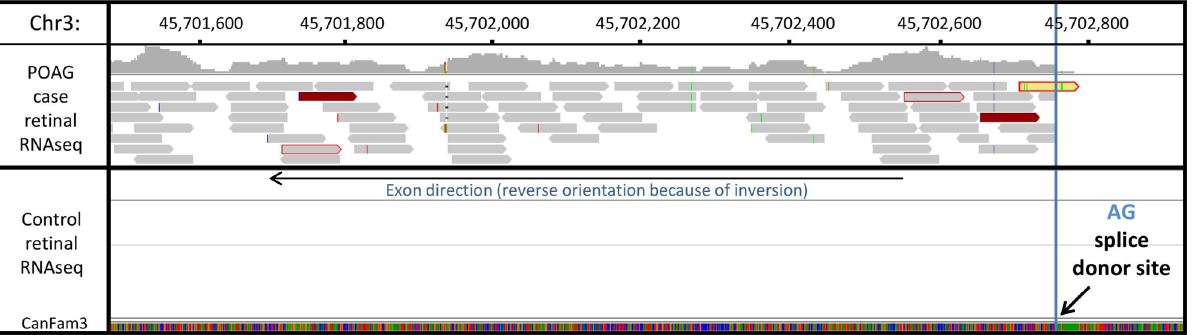
Fig 5. Example of novel exon formation through cryptic splicing. An example of a novel exon occurring due to a cryptic splicing event visualised through aligned RNAseq reads. A splice donor site and reads spanning to the previous exon (solid red) can be identified. There are no reads aligning to the region for the control individual (lower panel).